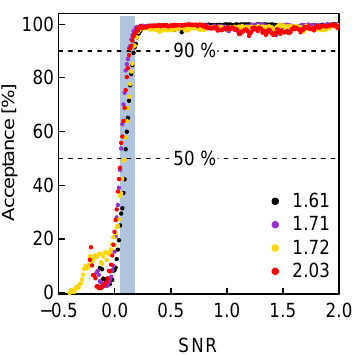
Figure 9. Acceptance (%) based on Welch’s t test with a p value of 0.01 of smoothed, not range-corrected, attenuated backscatter (Eq. 12) to be significantly higher than the noise floor (Eq. 13), binned by the corresponding signal-to-noise ratio (SNR, Eq. 15) for four selected cases (24h each; range 50–3000m shown for sim- plicity) of observations taken with different firmware versions (see legend). The shaded area marks the SNR region corresponding to acceptance levels of